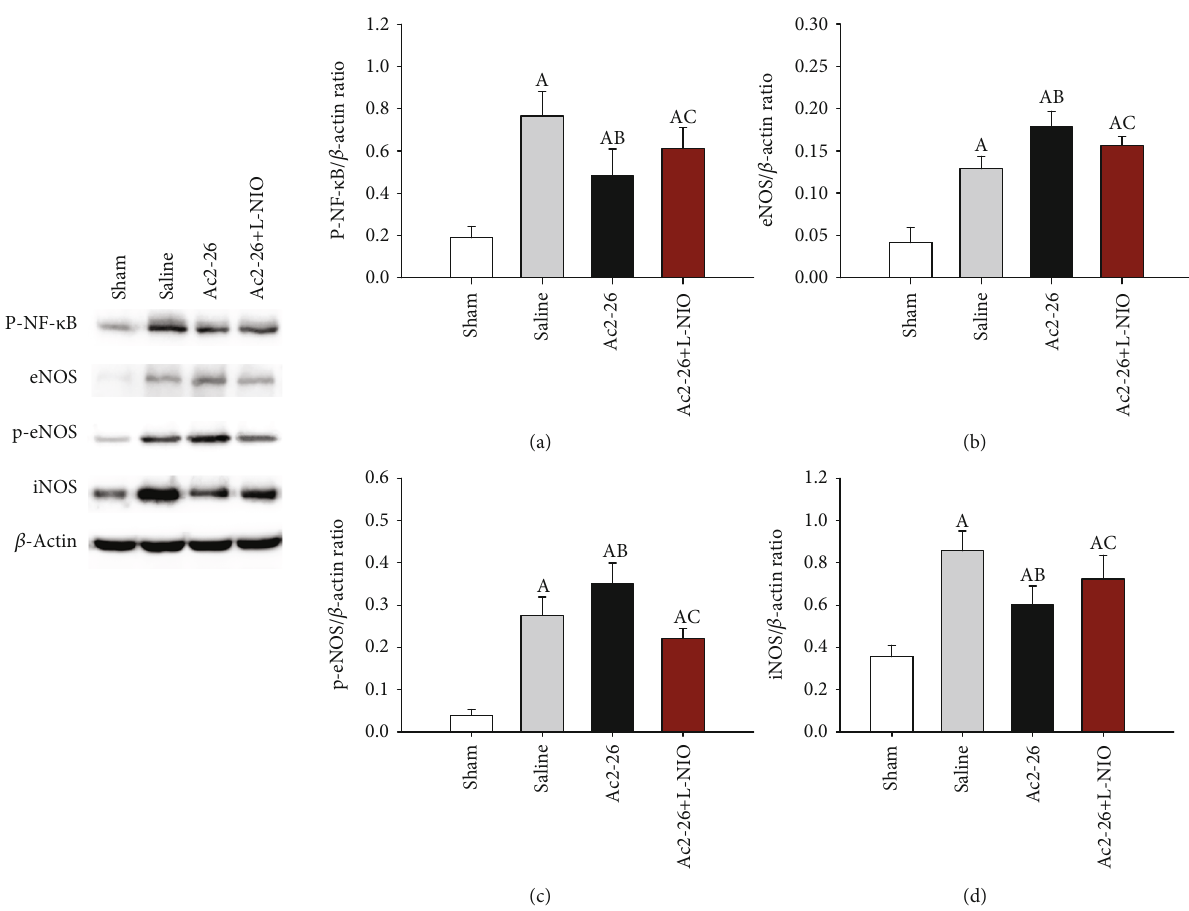
Figure 6: Expression of p-NF- κ B, eNOS, p-eNOS, and iNOS in brain tissue after ROSC. p-NF- κ B, eNOS, p-eNOS, and iNOS were measured using Western blot analysis 72 hours after ROSC. p-NF- κ B (a); eNOS (b); p-eNOS (c); and iNOS (d). Data are presented as mean ± SD . A P < 0 : 05 vs. sham group; AB P < 0 : 05 vs. saline group; AC P < 0 : 05 vs. Ac2-26 group (, sham group; , saline group; , Ac2-26 group; , Ac2-26 +L-NIO